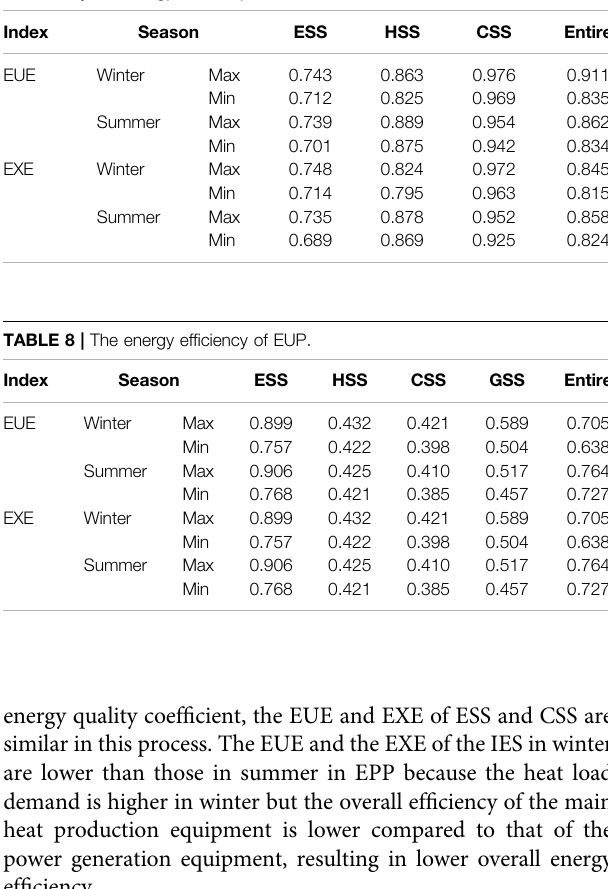
TABLE 7 | The energy ef fi ciency of ESP.